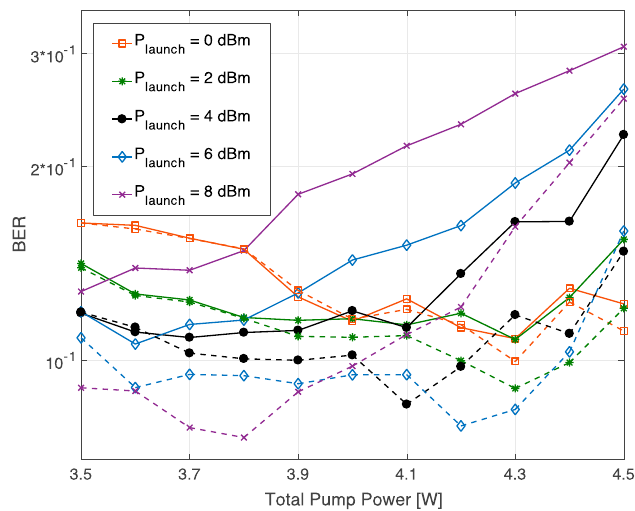
Figure 4. BER vs. total pump powers for di ff erent launch powers in a 240-km experiment with (dashed) and without (solid) DBP.